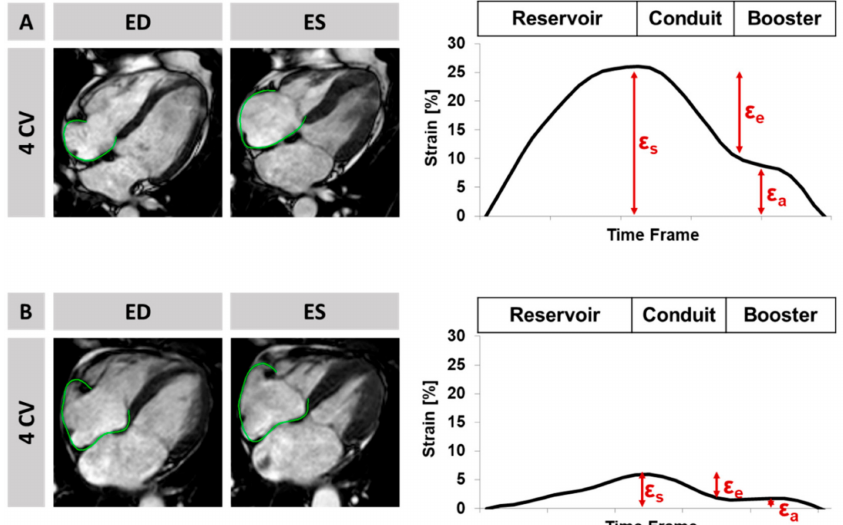
Figure 1. Feature-Tracking and Strain analysis on the left, display of a four chamber view (CV) with endocardially-tracked borders in the right atrium shown at end-diastole and systole, on the right, display of the corresponding curves of reservoir ( ε s ), conduit ( ε e ), and booster pump ( ε a ) for a patient with ( A ) normal left ventricular ejection fraction of 56% and no major adverse cardiac event during follow-up, and ( B ) normal left ventricular ejection fraction of 52% and a major adverse clinical event during